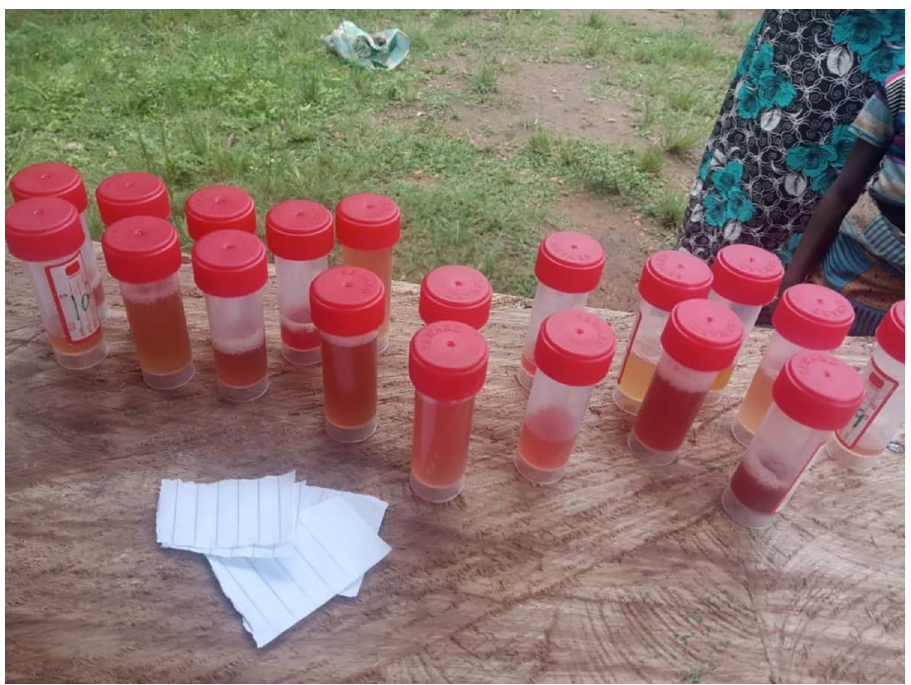
Fig 1. Samples of bloody urine collected during study procedures. Source: The authors took this picture on using their camera with the permission of the participants. Permission: The authors give permission to re-use this image.